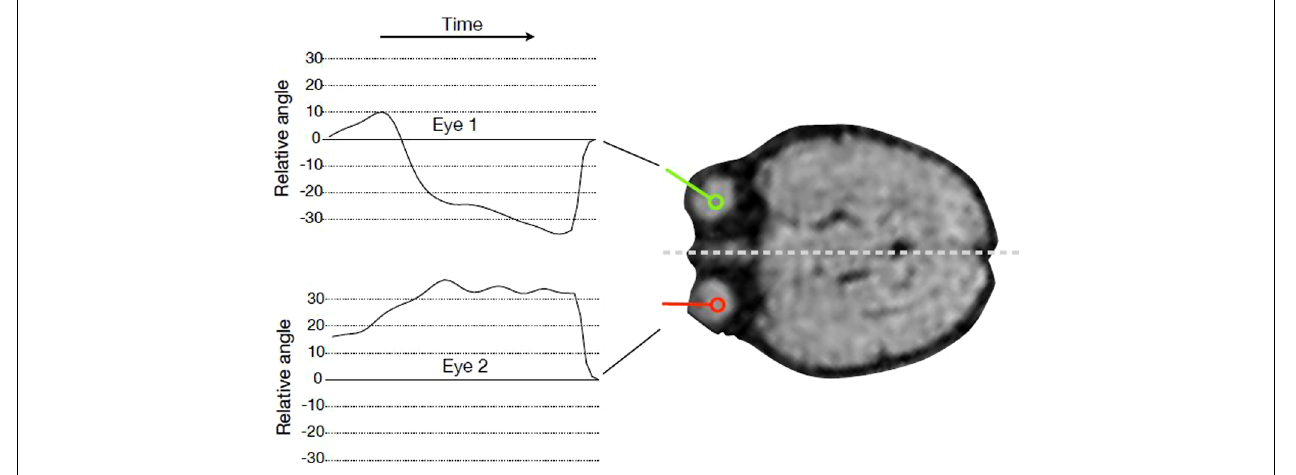
FIGURE 1 |Tracking eye movements over time. For every time point in the fMRI sequence, the angle of gaze direction relative to head orientation was recorded for every subject and both eyes.